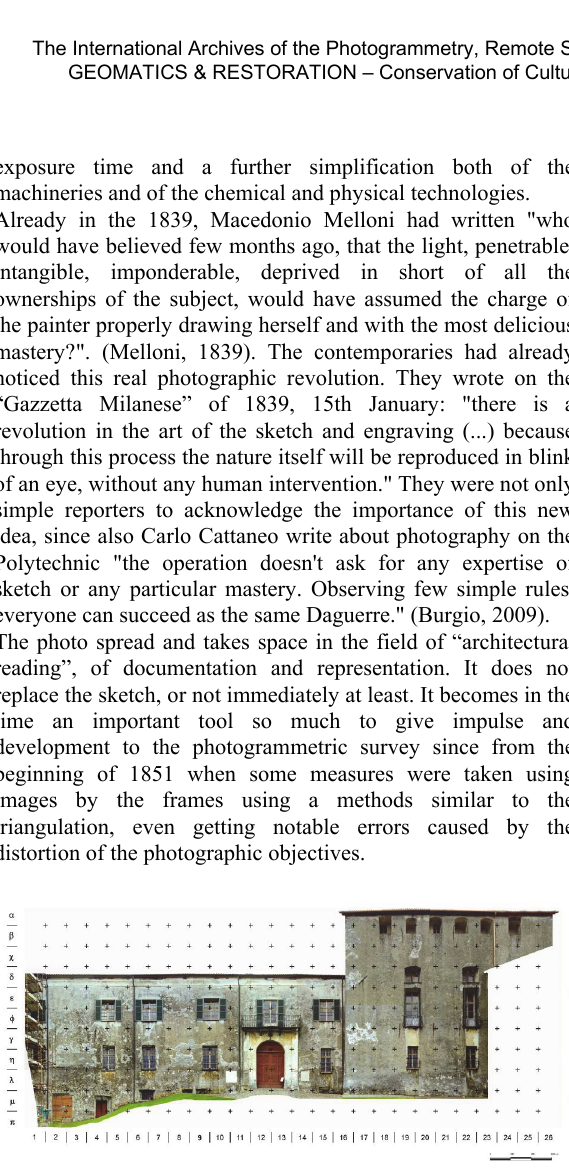
Figure 2: Castello di Masino (To) 1997: Orto-photographic survey with the system Real View (by Vectar, Arezzo). Employment of semiautomatic film reflex camera Canon Eos 500 with 50 mm lens and 100 ASA colour film Kodak. (T.